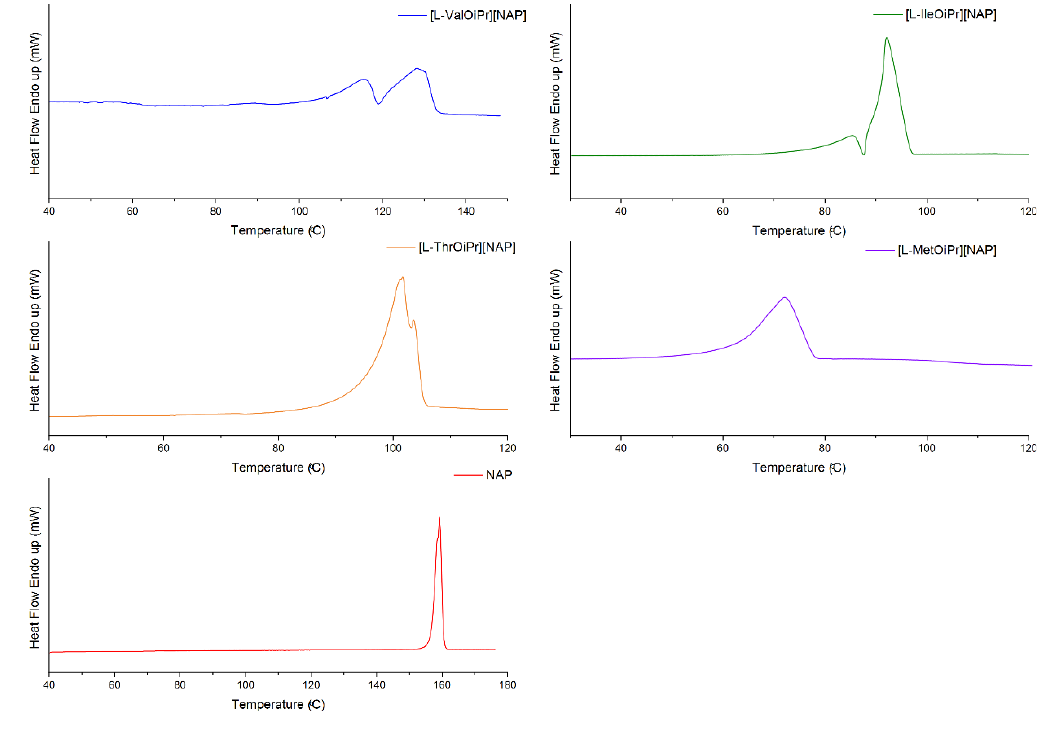
Figure 4. The DSC curves of first heating cycle of naproxen and naproxen salts: [L − ValOiPr][NAP] (blue), [L − IleOiPr][NAP] (green), [L − ThrOiPr][NAP] (orange), [L − MetOiPr][NAP] (purple), NAP (red).